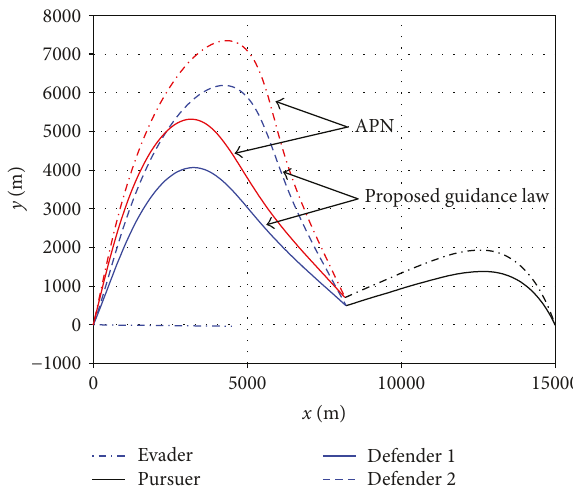
Figure 8: The acceleration variation of Defender